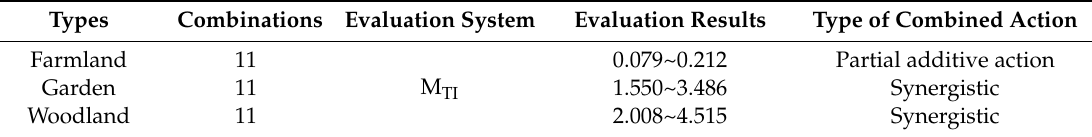
Table 9. Judgment of the combined toxicity of QNs in three soil